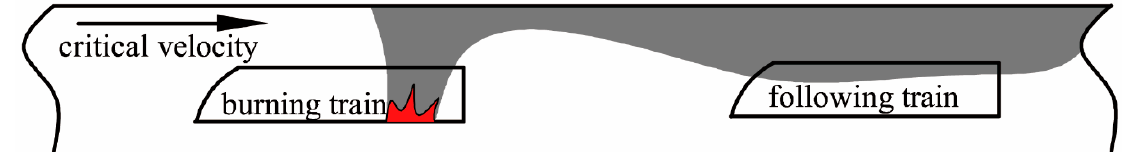
Figure 1. Schematic diagram of longitudinal ventilation.